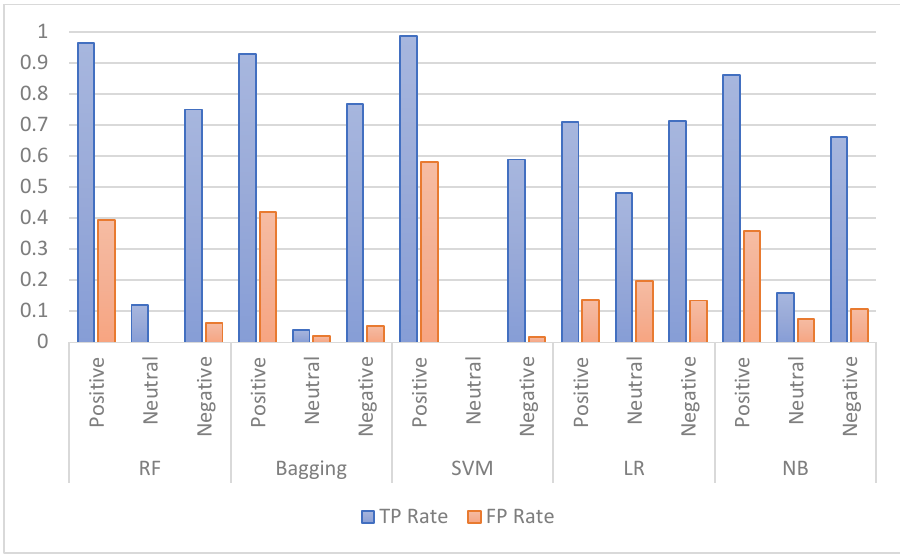
Figure 8. True-positive rate (TP Rate) and false-positive rate (FP Rate) of ML models with original sentiments using Word2Vec.